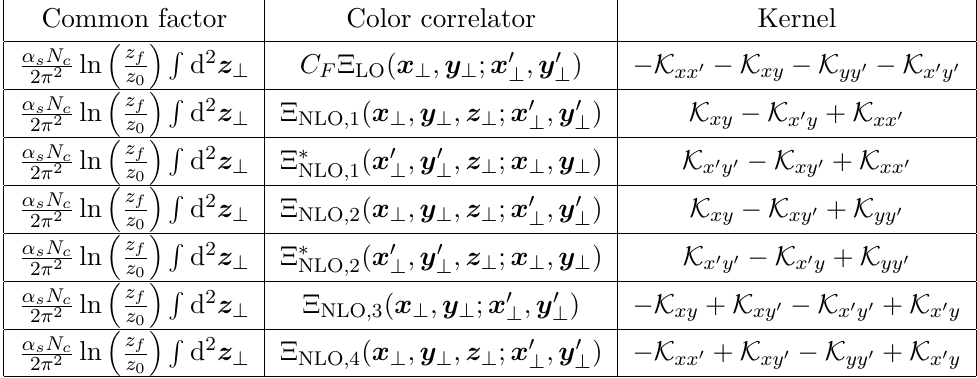
Common factor Color correlator